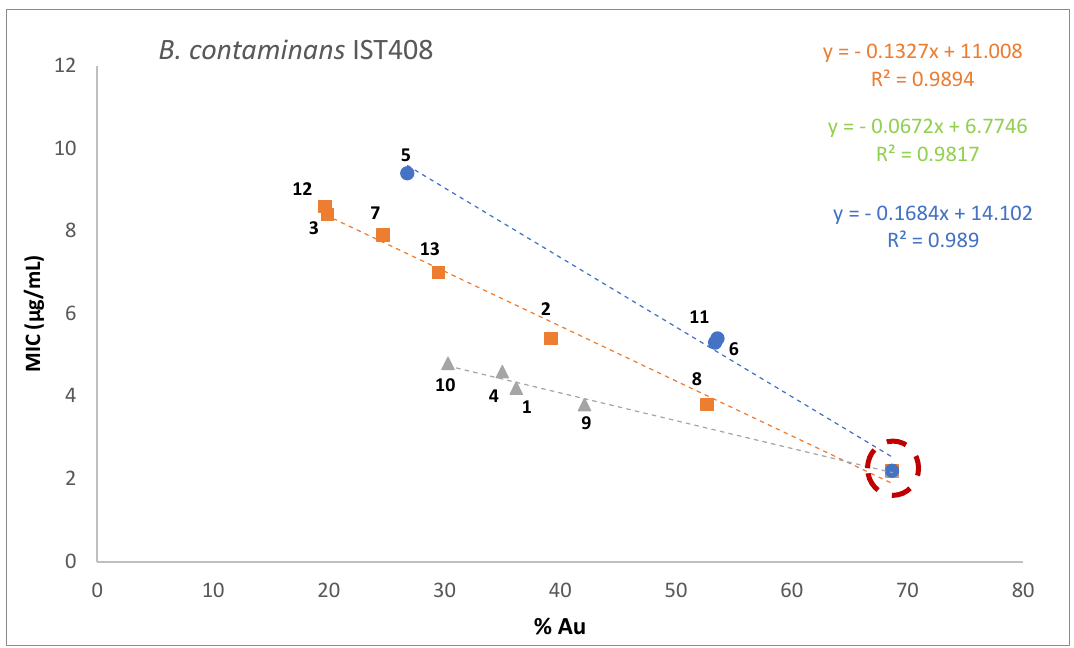
Figure 2. Relationship between gold content (% Au) of complexes and their MIC values against P. aeruginosa (numbers close to the marks refer to the number of the complexes, see Table 1).